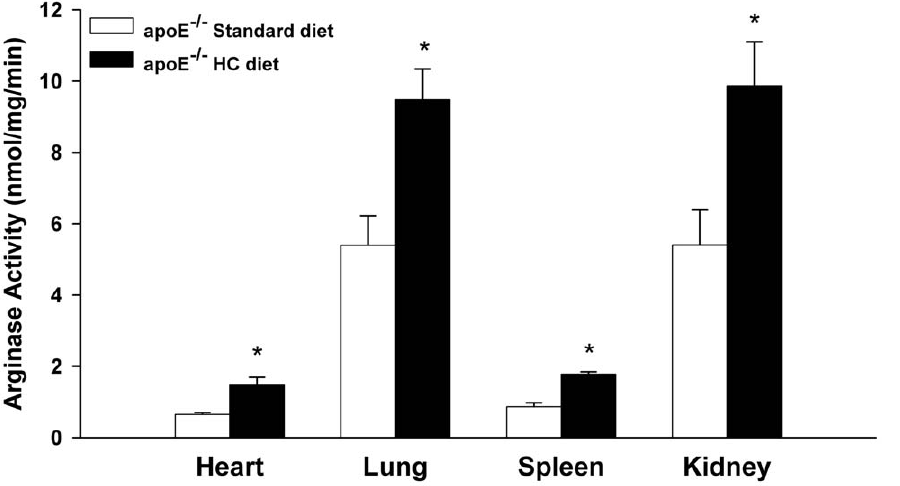
Figure 6. Induction of tissue arginase activities in apoE 2 / 2 mice on HC diet. Values are means 6 SE for n=6 in each group. *p , 0.05 vs standard diet.